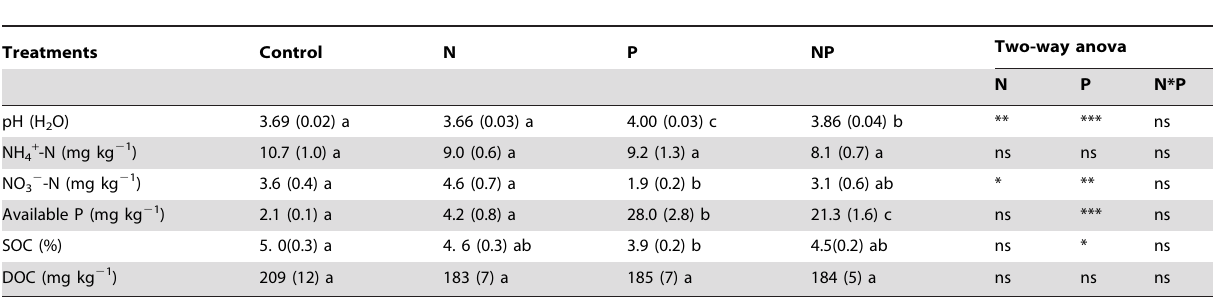
Table 2. Soil chemical properties after fertilization treatments, measured in June 2011.